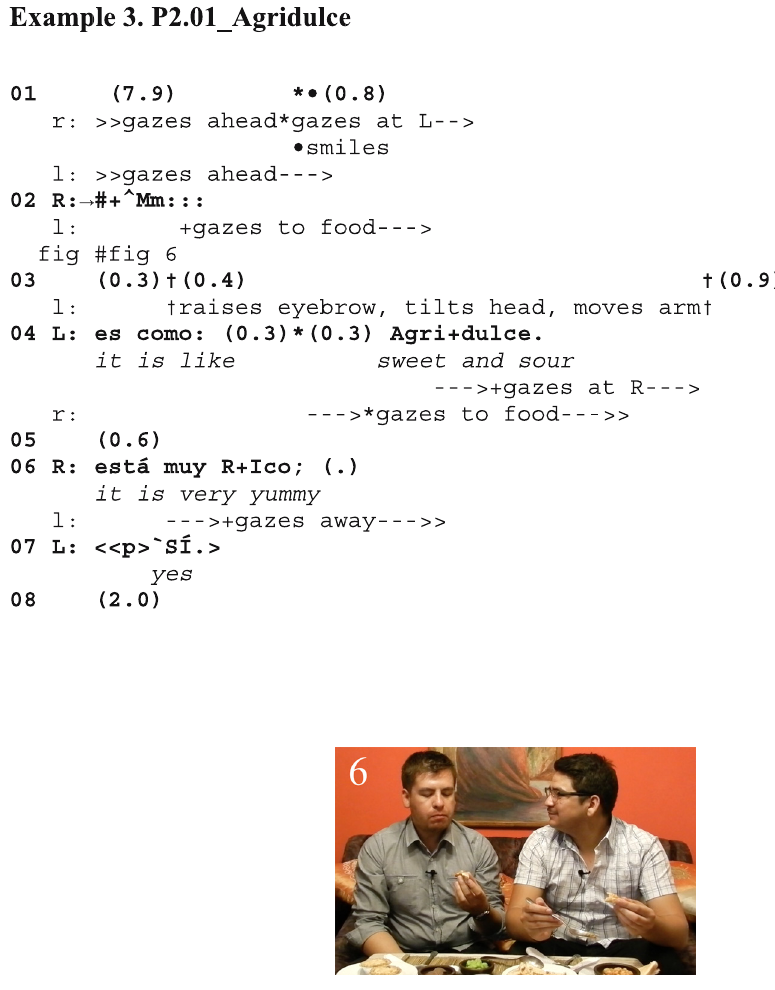
Figure 6: Screenshot illustrating the embodied behaviour at line